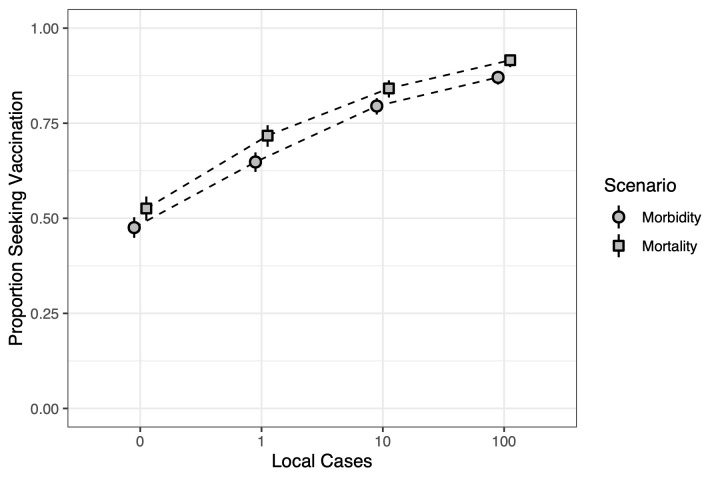
The proportion of respondents willing to seek vaccination given number of local cases of disease for the morbidity and mortality scenarios.The potential for mortality appears to be more strongly associated with willingness to vaccinate than morbidity. Zero local cases indicates that respondents are willing to vaccinate even if there are no local cases of the disease (though the disease does exist in the US). Slight offset in points and dotted lines are for visual aid.